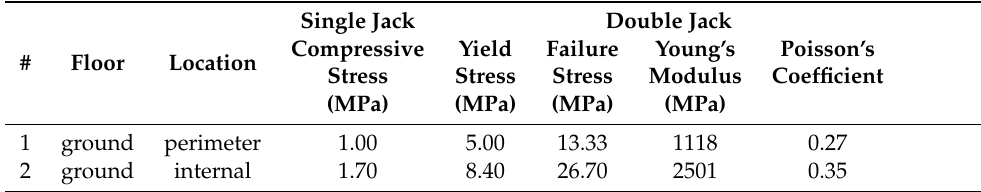
Figure 4. Flat jack tests. Location numbers according to Table 2. ( a ) Double flat jack test at location # 1. ( b ) Single flat jack test at location # 2. Table 2. Flat jack test